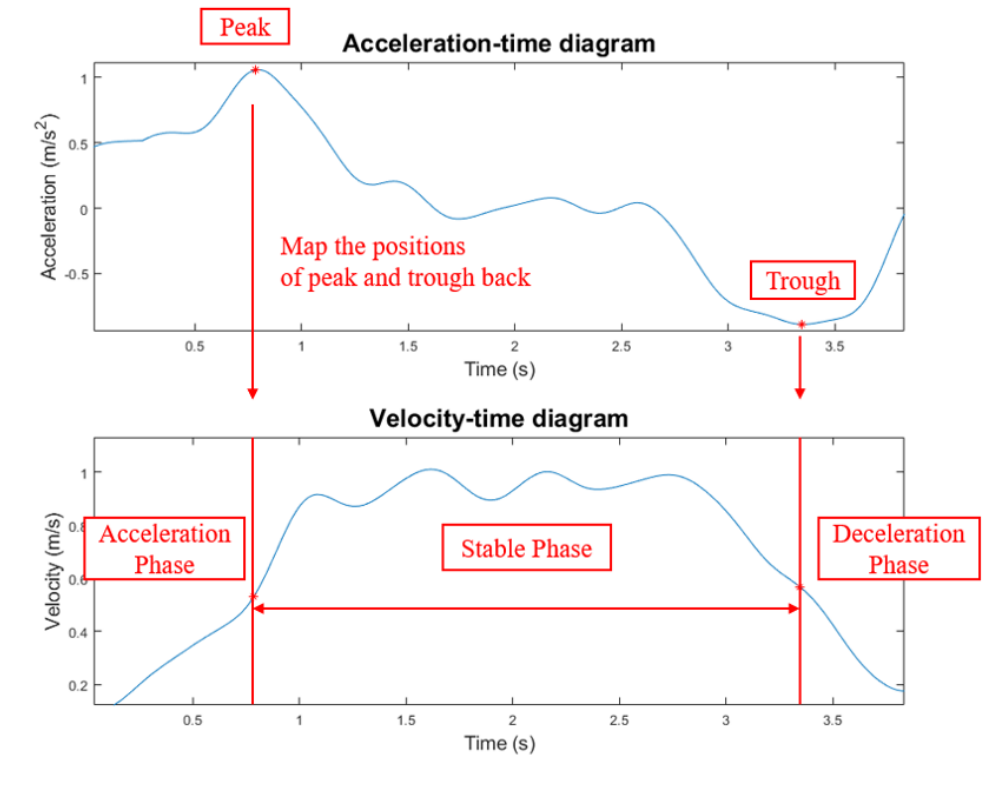
Figure 7. Example of results from the stable phase